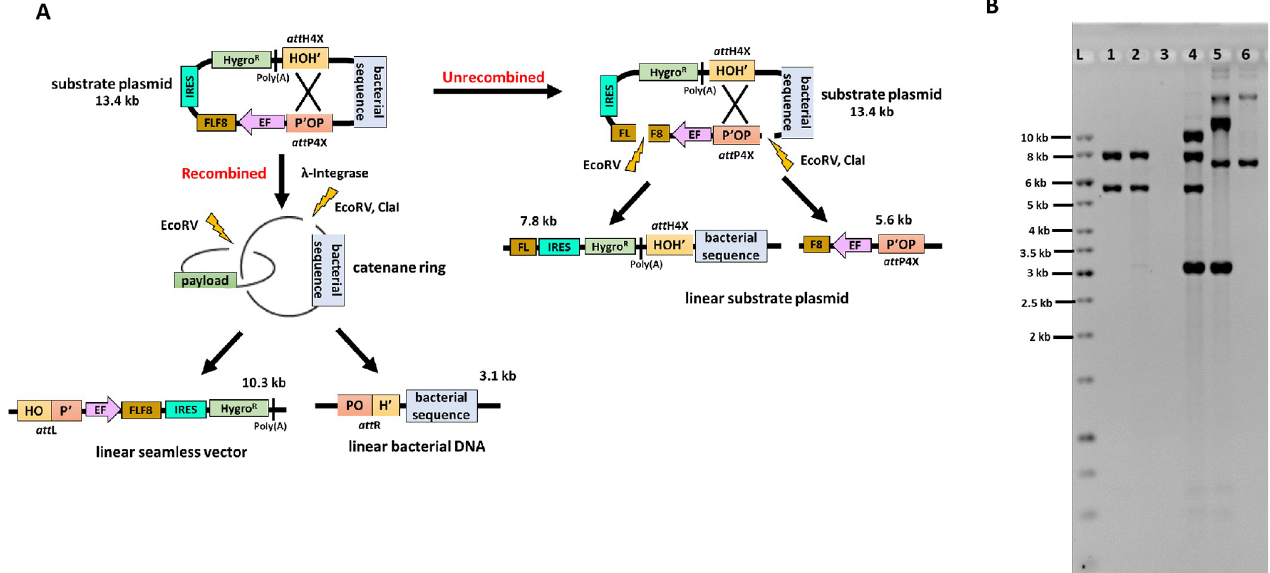
Fig 4. Production of maxi-seamless vectors in MG1655-ISC . ( A ) Map of recombination substrate p att P4x att H4x. The 21 bp att H4x and the 241 bp att P4x sequences are derivatives of the corresponding wild-type att B and att P sites. They flank the 3 kb bacterial backbone as direct repeats. Recombination deletes the bacterial backbone. Relative positions of relevant restriction sites are marked and predicted recombined and un-recombined restriction fragments indicated. ( B ) A suspension culture (10 ml) was induced for integrase expression by arabinose and further incubation for 70 minutes. Plasmid DNA was purified and analysed by agarose gel electrophoresis. L: 1 kb ladder; Lane 1: substrate vector (before transformation) digested with EcoRV generating two bands of size 7.8 kb and 5.6 kb for linear plasmid; Lane 2: transformed substrate vector (just before induction) digested with EcoRV generating two bands of size 7.8 kb and 5.6 kb for linear unrecombined plasmid; Lane 3: empty; Lane 4: substrate vector (after induction) digested with EcoRV generating four bands of size 7.8 kb and 5.6 kb for linear unrecombined plasmid, 10.3 kb for linear seamless vector and 3.1 kb for linear bacterial backbone; Lane 5: substrate vector (after induction) digested with ClaI generating three bands of size 13.4 kb for linear unrecombined plasmid, 3.1 kb for linear bacterial backbone and 10.3 kb for supercoiled seamless vector; Lane 6: substrate vector (after induction) digested with ClaI and T5 exonuclease generating a supercoiled seamless vector. Note that the additional high molecular weight DNA is most likely the result of intermolecular recombination between seamless vector generating dimers.